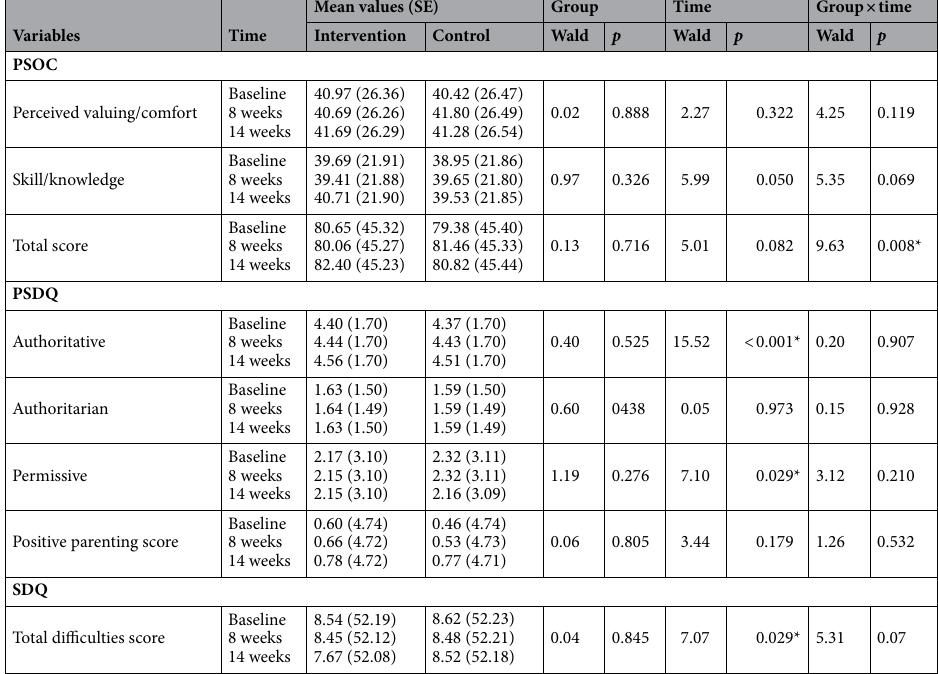
Table 4. Parents’ and children’s outcomes on generalised estimating equation (GEE) analysis. GEE Analysis was based on repeated measures taking into consideration the interaction of group by time. PSOC Parenting Sense of Competence, PSDQ Parenting Styles and Dimensions Questionnaire, SDQ Strengths and Difficulties Questionnaire. * p < 0.05; SE standard